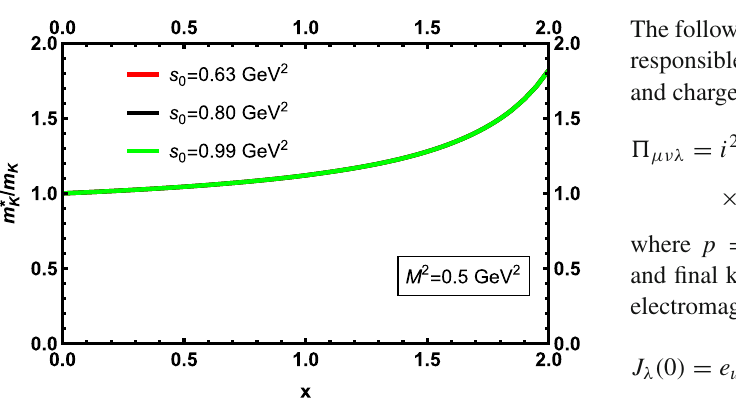
Fig. 4 The density dependence of the ratio of in-medium to vacuum mass for K + meson at M 2 = 0 . 5 GeV 2 and different continuum thresh- olds